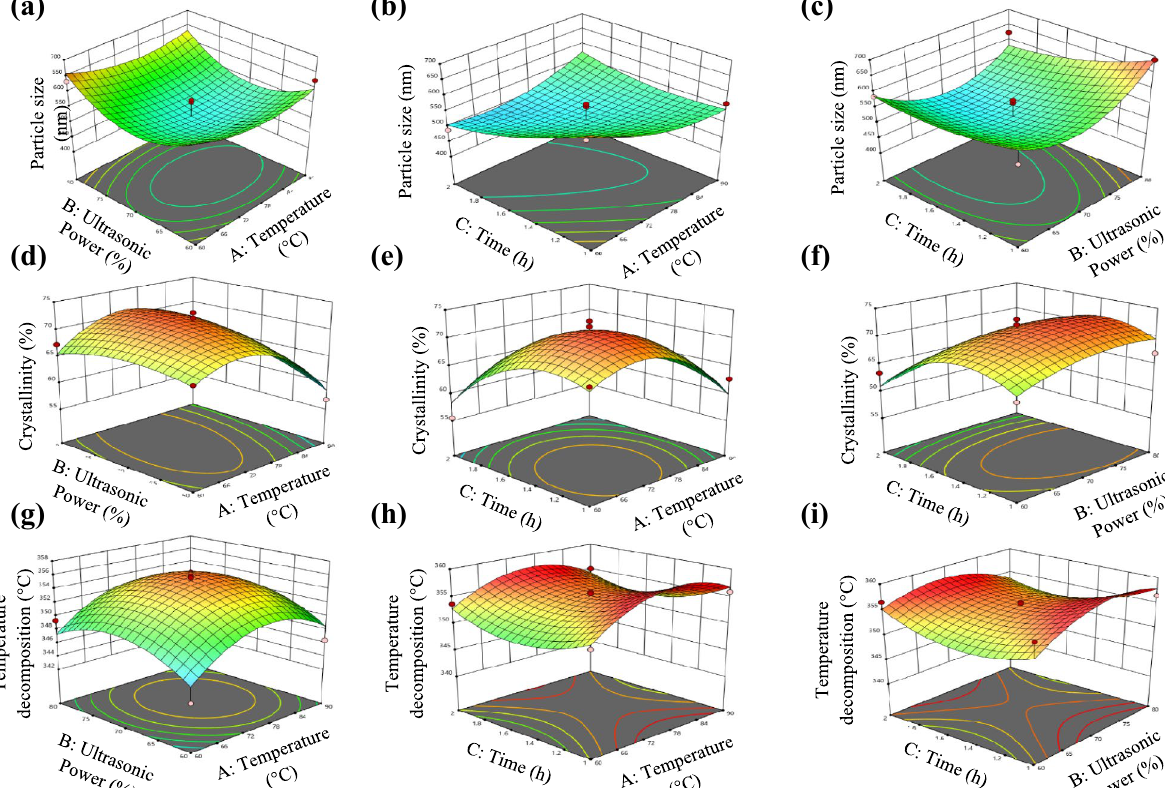
Fig. 2 Response surface plots depicting the interaction of a temperature and ultrasonic power, b temperature and time, c ultrasonic power and time on particle size of cellulose, d temperature and ultrasonic power, e temperature and time, f ultrasonic power and time on crystallinity of cellulose, g temperature and ultrasonic power, h temperature and time, and i ultrasonic power and time on temperature decomposition of paper waste